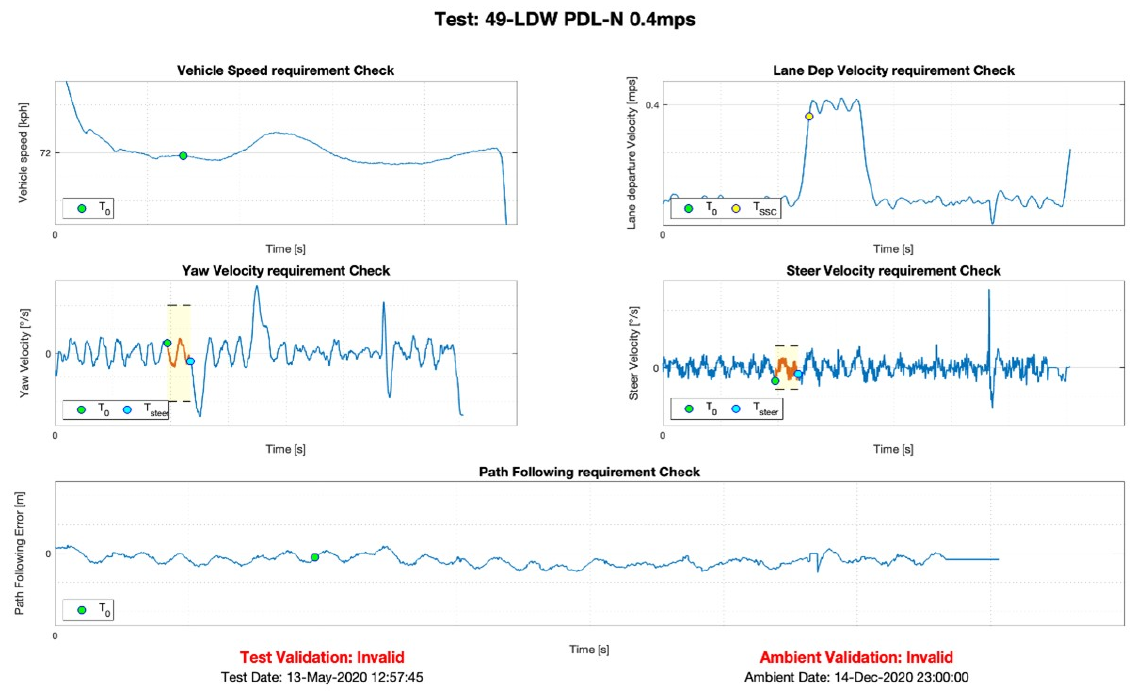
Figure 18. Post-processing results for an invalid test LDW.